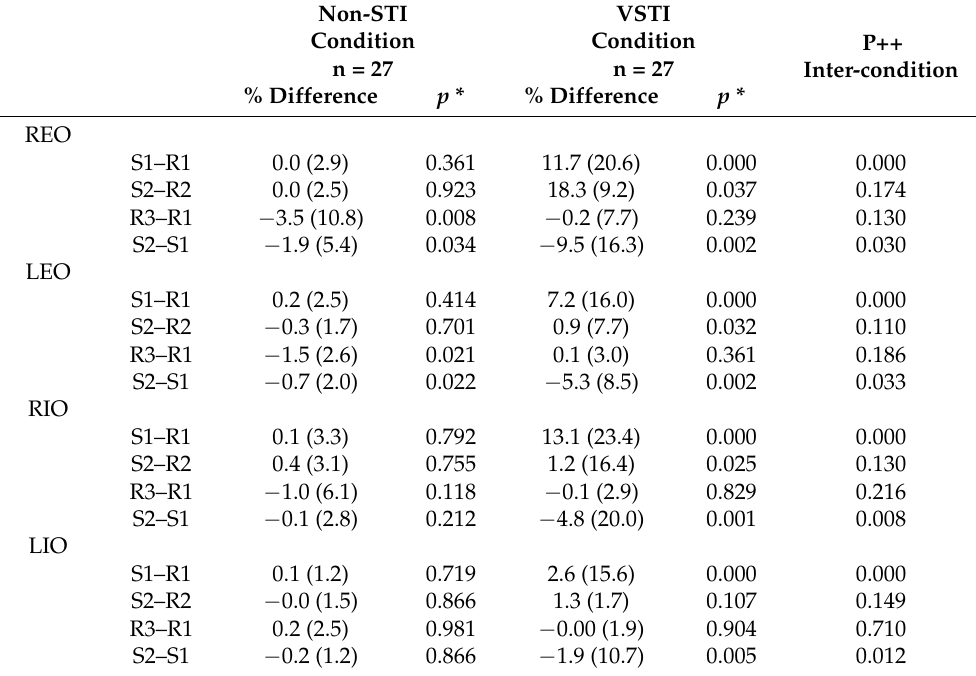
Table 3. Percentage differences found between the phases of each muscle experimental